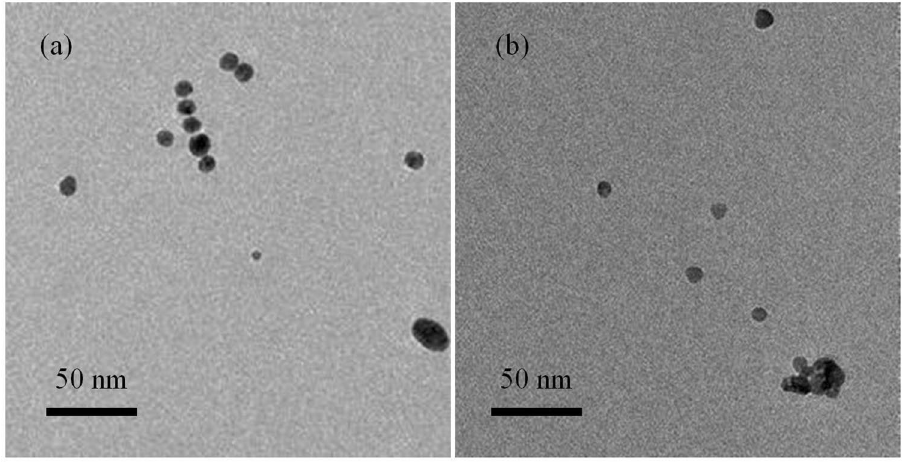
Figure 4. Transmission electron microscopy images of ( a ) AgNPs and ( b ) the AgNPs in the presence of Hg(II)